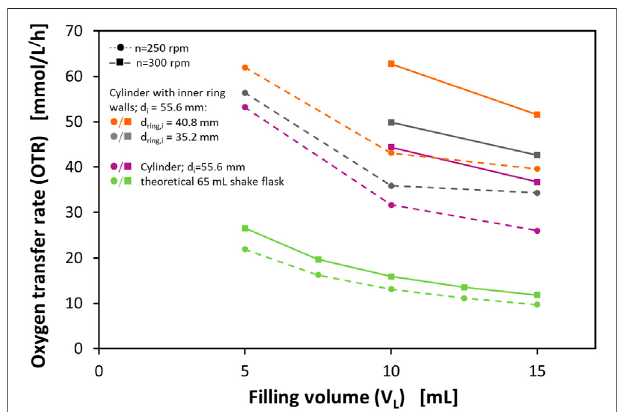
FIGURE 2 | Maximum oxygen transfer capacities (OTR max ) of a cylindrical vessel and two different perforated ring fl asks in a 0.5 M sul fi te oxidation system and calculated OTR max levels for a theoretical 65 ml shake fl ask in 0.5 M sul fi te oxidation system according to Meier et al. (2016). The cylindrical vessel and the perforated ring fl asks have an inner diameter of d i = 55.6 mm, the perforated ring fl asks have ring diameters of d ring,i = 35.2 mm, and d ring,i = 40.8 mm, respectively, wall thicknesses of the rings of d wall = 1.4 mm and d wall = 1.6 mm, respectively, and 4 equidistant perforations directly adjacent to the bottom with a size of 2 mm × 2 mm; Experimental conditions: 0.5 M Na 2 SO 3 , 0.012 M phosphate buffer, 10 − 7 M CoSO 4 , and 2.4 × 10 − 5 M bromothymol blue; initial pH = 8; temperature T = 21 ° C; shaking diameter d 0 = 25